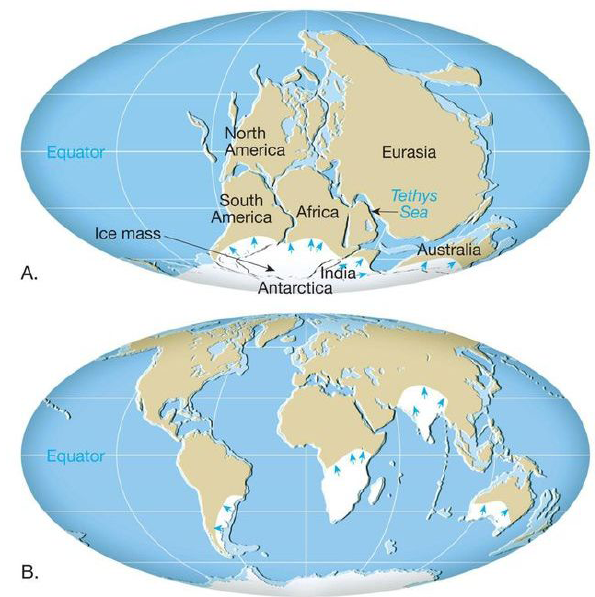
Figure 2. (a) The supercontinent Pangaea existed approximately between 350–260 million years ago. Ice sheets are located close to the south pole of the Earth. (b) Present position of the con- tinents. Evidence of old ice sheets is located on different land- masses. Reprinted from Essentials of Geology (p. 282) by Lutgens et al. (2012). © 2012, 2009, 2006 by Pearson Education,